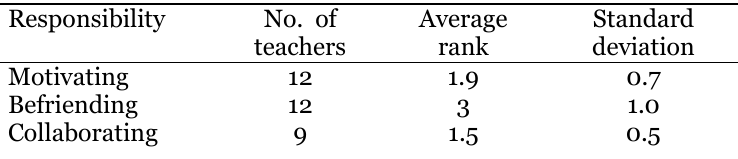
Teacher-Reported Responsibilities of Peers